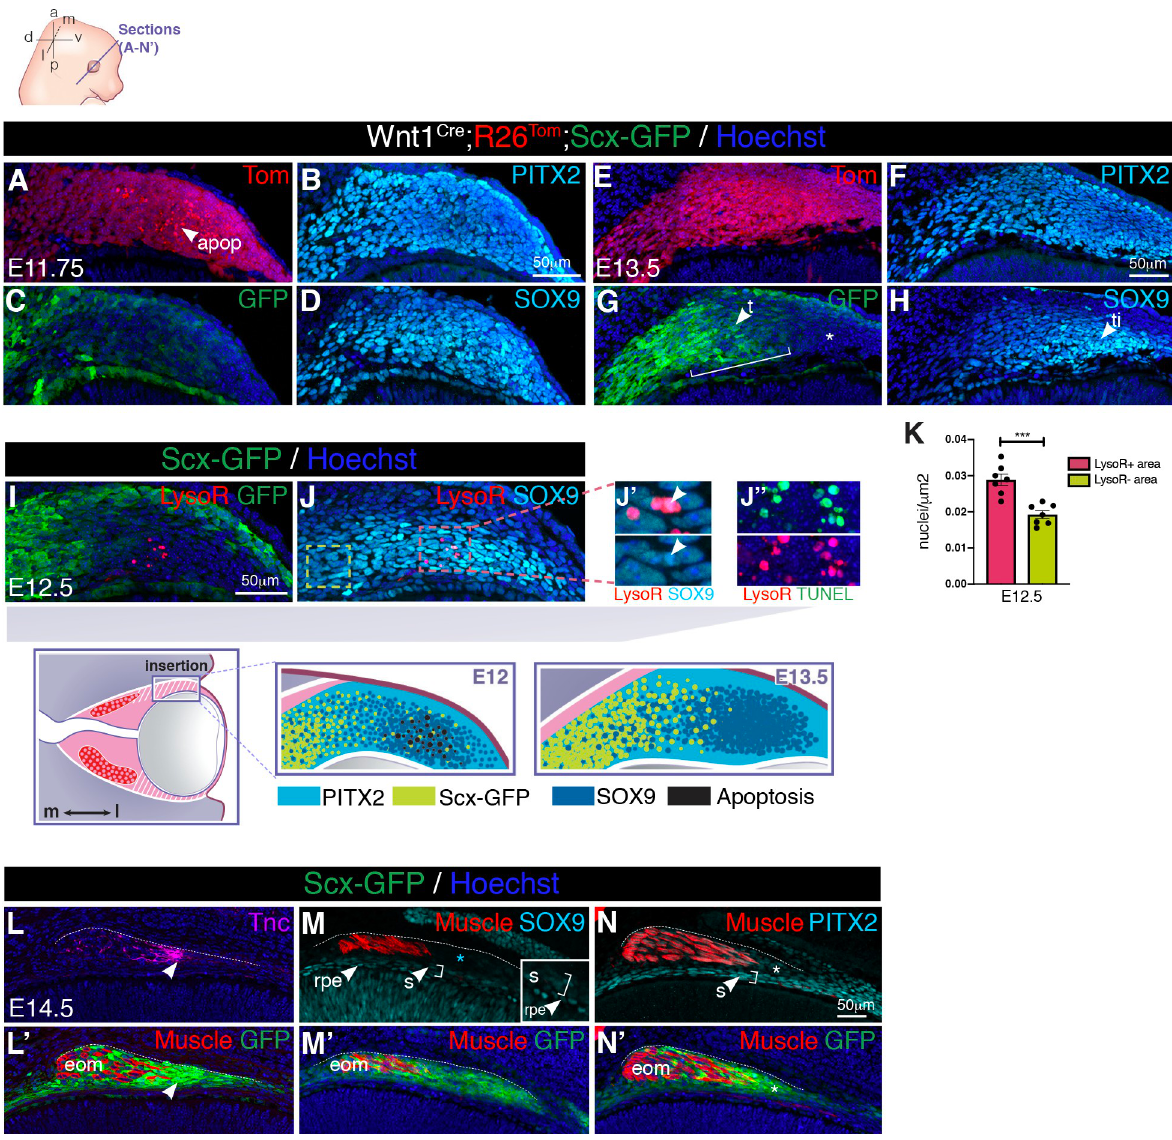
Fig 3. Developmental time course of EOM insertions in the POM. (A-D) Immunostaining of lateral POM in coronal sections of E11.75 Tg : Wnt1 Cre ;R26 Tom ;Scx-GFP embryos for the indicated markers. B , Immunostaining of section adjacent to the one shown in ( A, C, D ; channels split for clarity). (E-H) Immunostaining of lateral POM in coronal sections of E13.5 Tg : Wnt1 Cre ;R26 Tom ;Scx-GFP embryos for the indicated markers. G , Immunostaining of section adjacent to the one shown in ( E, F, H ; channels split for clarity). Bracket show overlap between Scx-GFP and SOX9 expression domains (high-magnification views in S3C” Fig). The asterisk in G points to Scx-GFP -negative SOX9+ lateral-most POM at the insertion site. (I,J) Immunostaining of lateral POM in coronal sections of E12.5 Tg : Scx-GFP embryos pretreated with LysoR. Arrowheads in J’ point to LysoR + SOX9+ cells. ( J” ) TUNEL and LysoR staining of a section adjacent to the one shown in ( I,J ). (K) Quantification of the total number of SOX9+ cells per square-micrometer in LysoR+ regions (red square, J ) and more medial LysoR-negative regions (yellow square, J ). Mann–Whitney test. Cell density was 33% higher in the LysoR+ area compared with the more medial POM. See S1 Data for individual values. (L-N’) Immunostaining on coronal sections of E14.5 Tg : Scx-GFP embryos. ( L,L’ ) Tnc and Scx-GFP co-localize in tendons at level of insertion (arrowhead). ( M,M’ ) SOX9 expression in the POM is greatly reduced at the insertion site and no longer overlaps with Scx-GFP (asterisk, cyan). Low levels of SOX9 expression in the RPE and sclera. ( N,N’ ) PITX2 remains expressed in the POM at the insertion site overlaping with Scx-GFP (asterisk) and in the sclera. MyHC ( L’ ) and SMA ( M-N’ ) were used to label EOM muscle. Dashes in L-N were drawn according to GFP labeling in L’-N’. Images in A-N’ correspond to insertion site of superior rectus muscle in the POM as shown in the scheme. ( n = 3 per condition). a, anterior; apop, apoptosis spots; d, dorsal; E, embryonic day; eom, extraocular muscle; l, lateral; LysoR, LysoTracker Red; m, medial; p, posterior; POM, periocular mesenchyme; rpe, retinal pigmented epithelium; s, sclera; t, tendon; ti, tendon insertion, v, ventral.